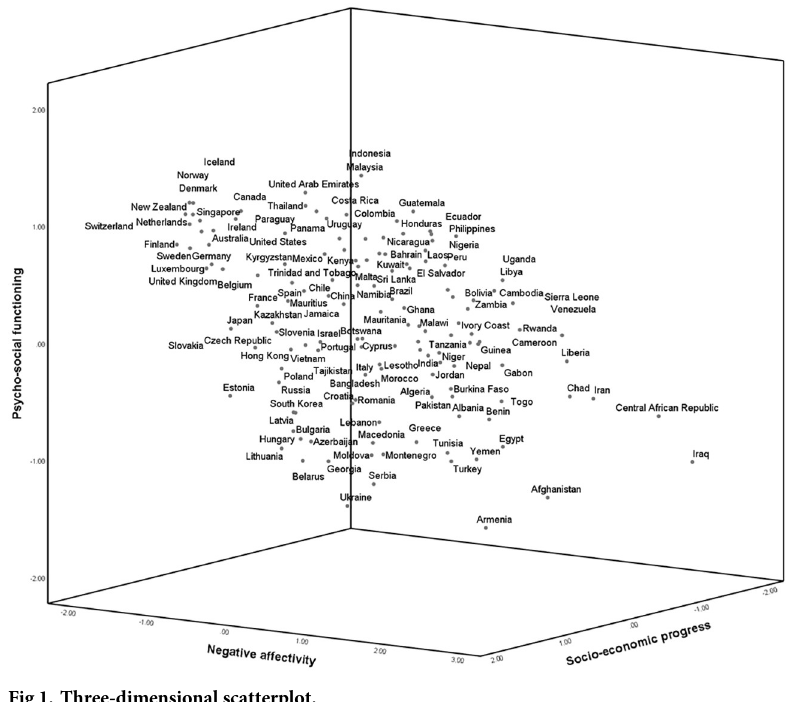
Fig 1. Three-dimensional